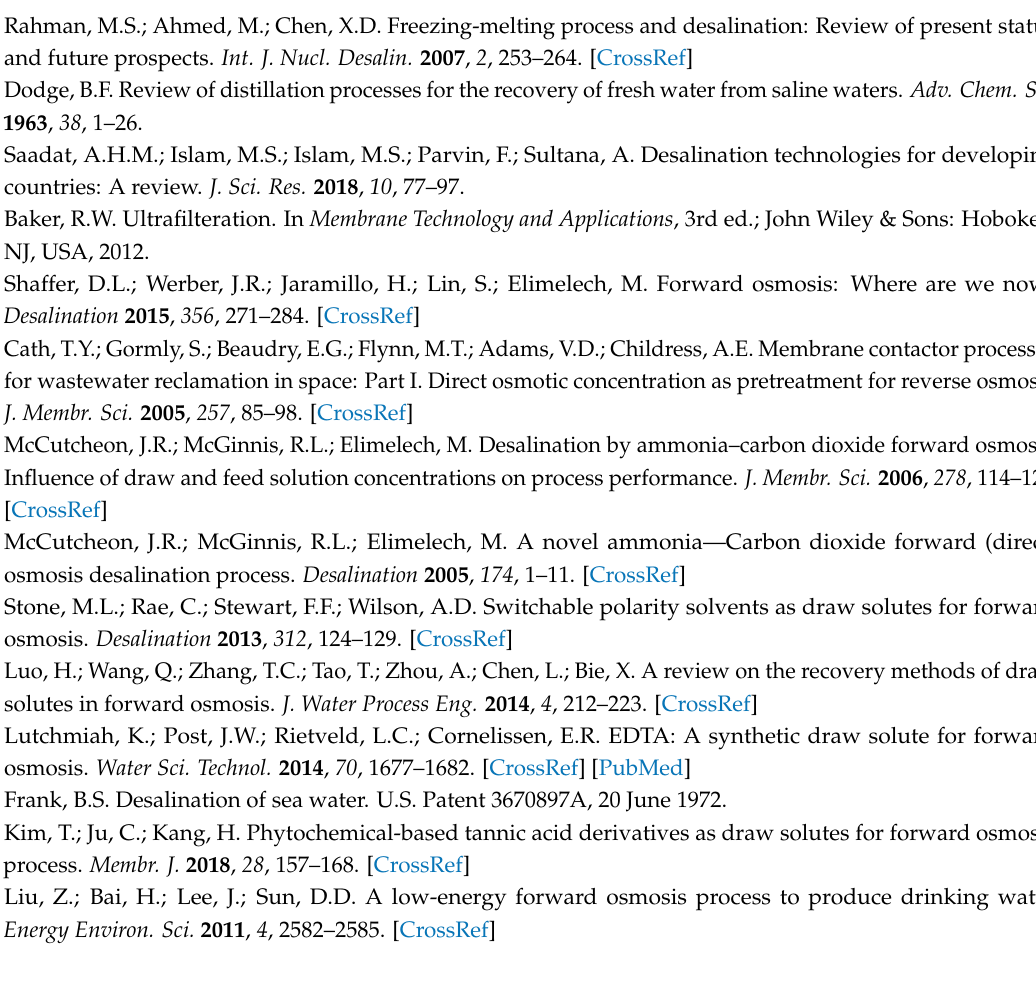
Figure S1: Proton nuclear magnetic resonance ( 1 H-NMR) spectrum of octane-1,8-diylbis(tri- n -butylphosphonium) bromide (BP8Br 2 ), Figure S2: 1 H-NMR spectrum of hexane-1,6-diylbis(tri- n -butylphosphonium) bromide (BP6Br 2 ), Figure S3: 1 H-NMR spectrum of butane-1,4-diylbis(tri- n -butylphosphonium) bromide (BP4Br 2 ), Figure S4: 1 H-NMR spectrum of octane-1,8-diylbis(tri- n -butylphosphonium) 4-vinylbenzene-sulfonate (SSBP8), Figure S5: 1 H-NMR spectrum of hexane-1,6-diylbis(tri- n -butylphosphonium) 4-vinylbenzene-sulfonate (SSBP6), Figure S6: 1 H-NMR spectrum of hexane-1,4-diylbis(tri- n -butylphosphonium) 4-vinylbenzene-sulfonate (SSBP4), Figure S7: 1 H-NMR spectrum of tetrabutylphosphonium 4-vinylbenzenesulfonate